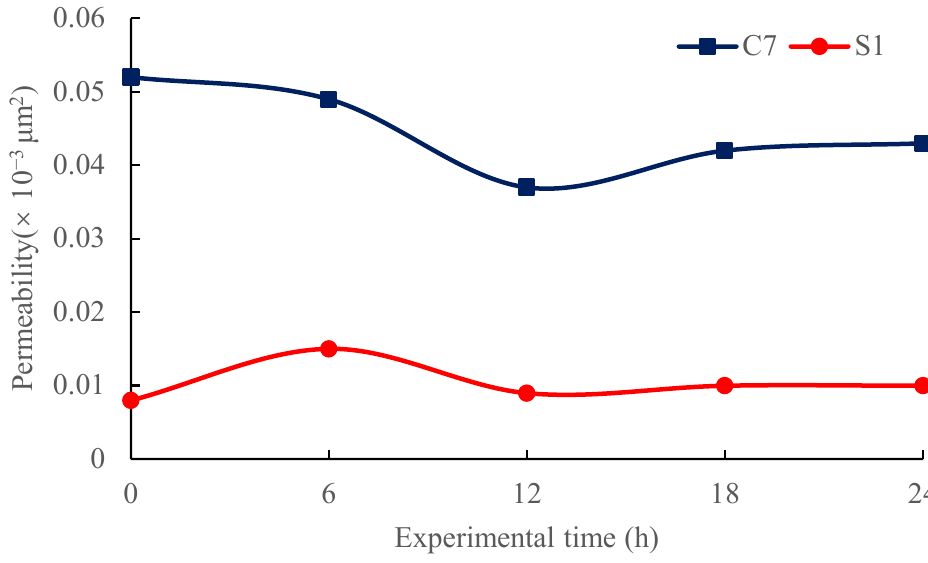
Figure 12. Permeability changes of short-interval (24 h) experiment.